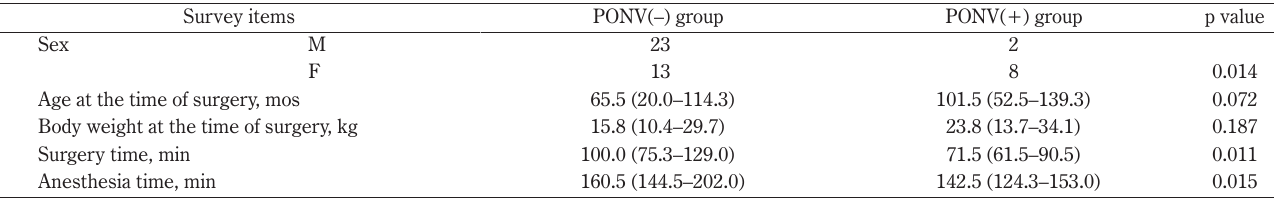
Table 1 Comparison of survey items between the PONV(–) and PONV(+) groups Survey